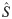
Binding strength evolutions.Each box corresponds to a different phenotype, with marker styles indicating interaction topology. Line colours (online) match the box colour of the direct ancestor, with “open” markers (print) indicating the ancestor is from an upper panel. Because phenotypes can transition at markedly different times (with 4% of simulations never discovering the rightmost phenotypes), the dynamics were aligned by counting the generations after that phenotype was discovered. Individual simulations are noisy due to their stochastic nature, but averaging over 10,000 simulations yielded the stable trends shown here. Values for S^ within individual simulations typically fluctuated within ±0.01 of the mean. Mean trends stabilized quickly, so results were truncated after 250 generations. Black dashed lines in the panels are from the Markov prediction. The * again indicates the three nondeterministic assemblies. Interface strengths in deterministic assemblies evolve predictably, while nondeterministic assemblies diverge rapidly.